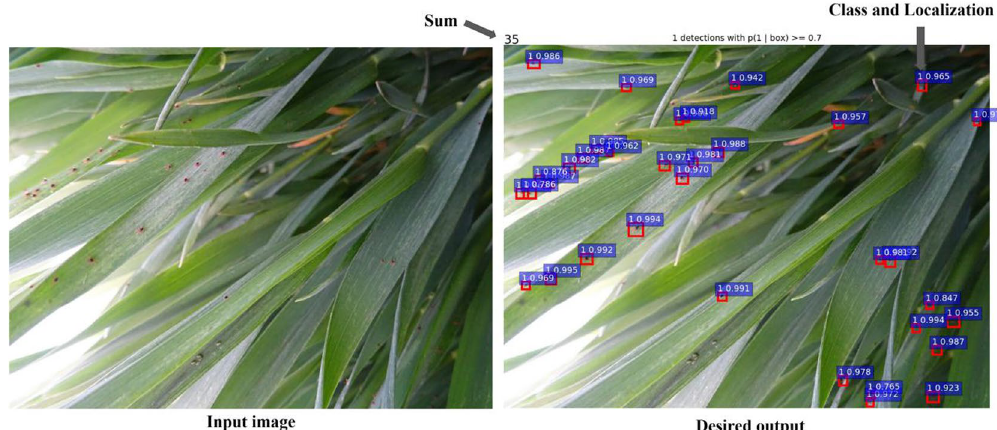
Figure 1. Classification and localization of wheat mites. Our method aims to detect both the classification and localization of wheat mites. At the same time, this method outputs the total number of wheat mites in the original images. The left graph shows the case of original image, while the right one illustrates classification and localization of wheat mites. Here, the location of wheat mite in the image is shown as a red bounding box containing the identified wheat mites, the possibility of detected bounding box is shown in blue box, and the total number of 35 detected wheat mites is also shown in the right